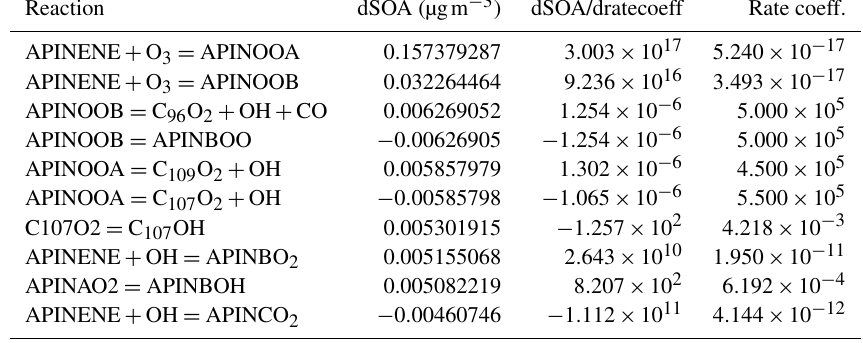
Table 2. Sensitivities of SOA mass with respect to gas-phase rate coefficients. The units of the last two columns depend on the number of reactants.